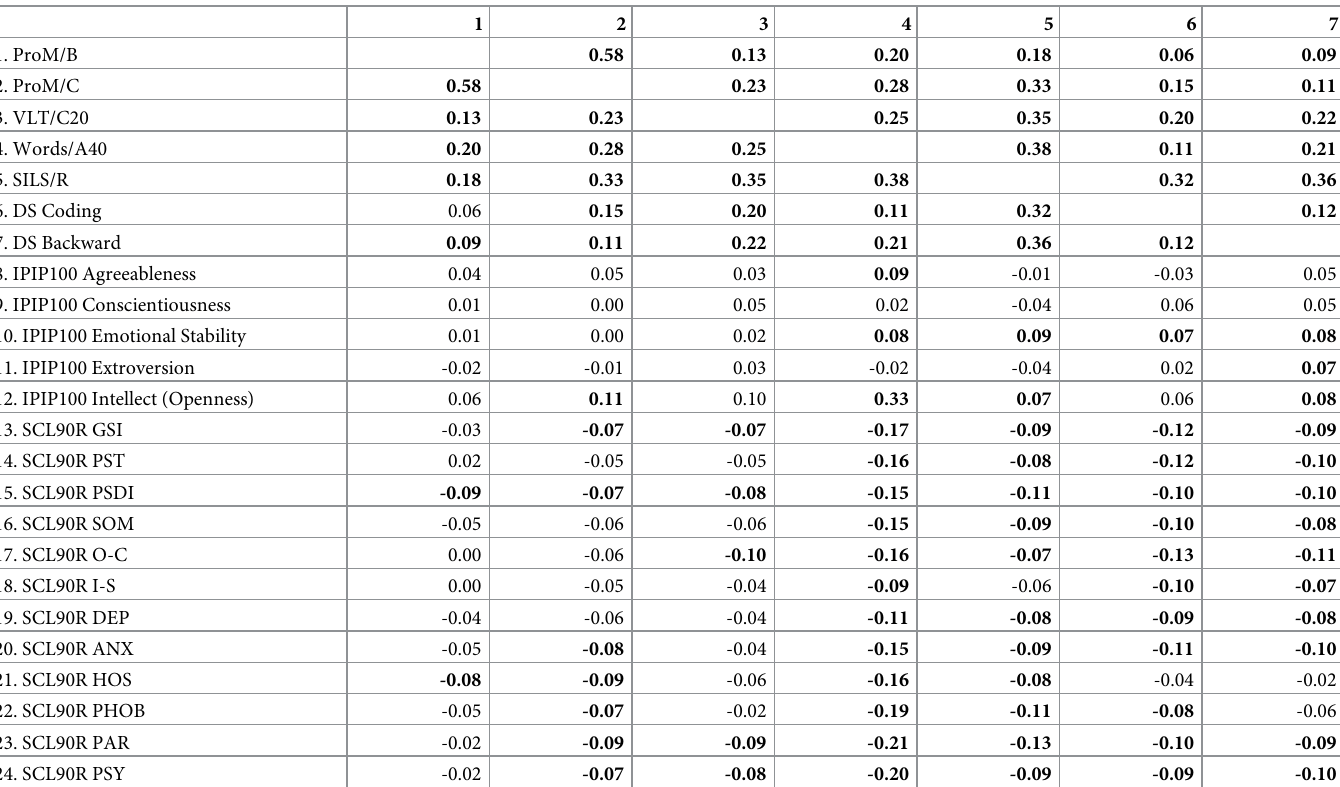
Table 5. Correlation matrix for